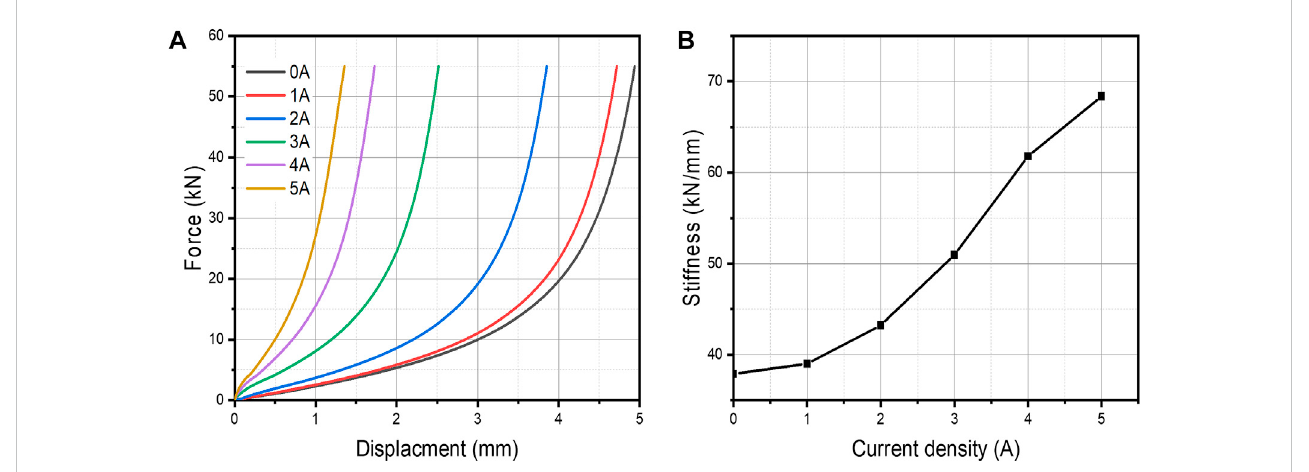
FIGURE 8 Load curve (A) and static stiffness (B) of MRE railway pad at different current on magnetic controlling